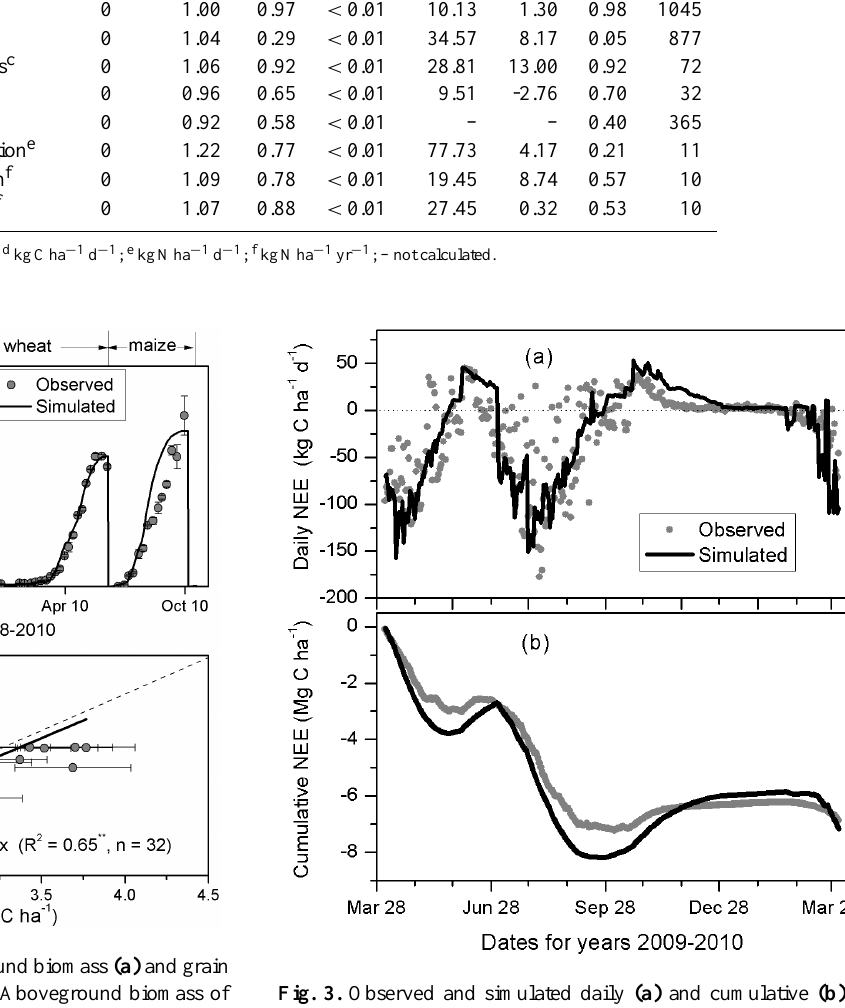
Linear regression